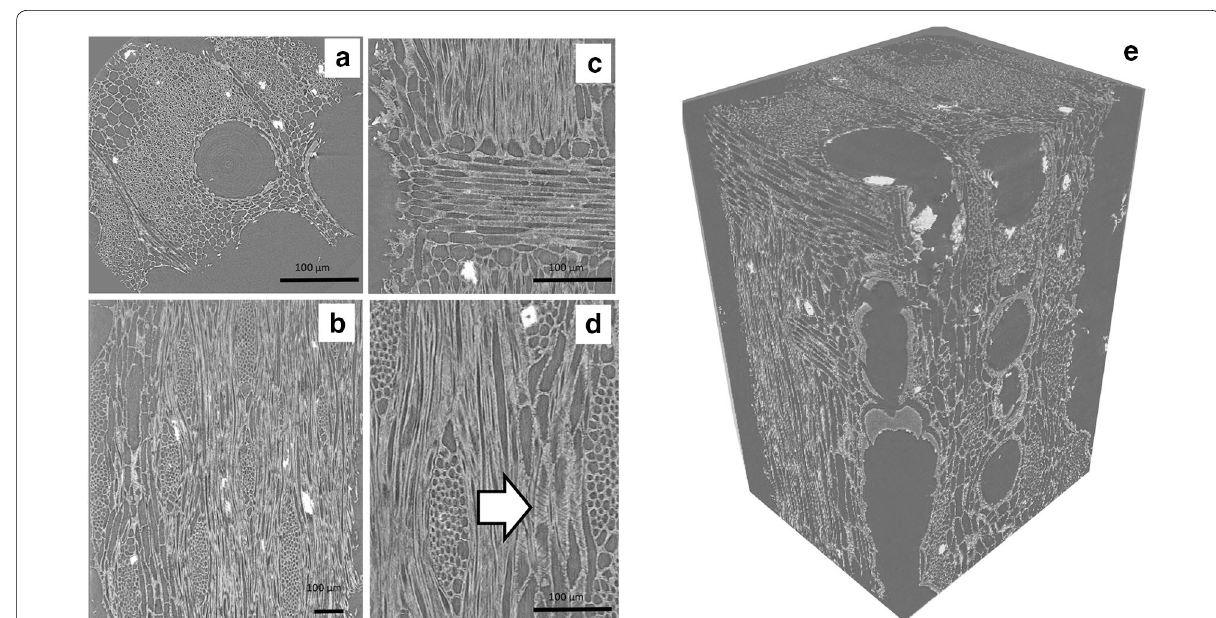
Fig. 2 Pseudo-sections constructed from the SRX-ray μCT dataset from SPring-8 for female deity 1 (a in Table 1). a cross-section, b tangential section, c radial section, d magnified image of tangential section and e 3D